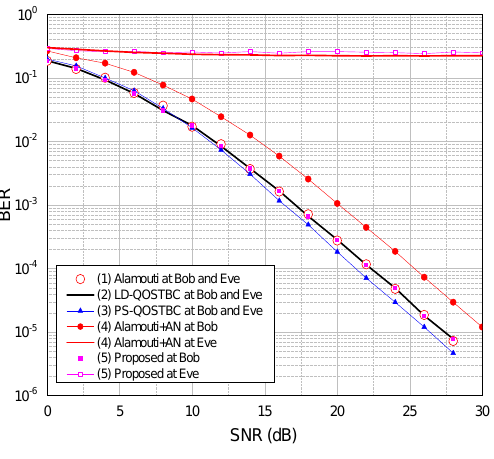
Figure 4. Comparison of bit error rate (BER) performances for various STBC-based PLS schemes over a Rayleigh fading channel at the legitimate (Bob) and illegal (Eve)